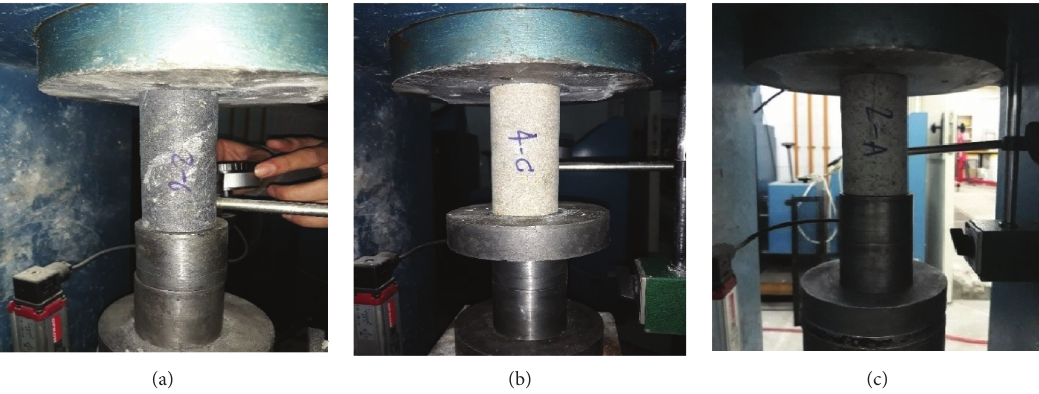
Figure 7: Three different rock specimens prepared for testing: (a) Altered Magnetite, (b) Rhyodacite, (c) Granite.